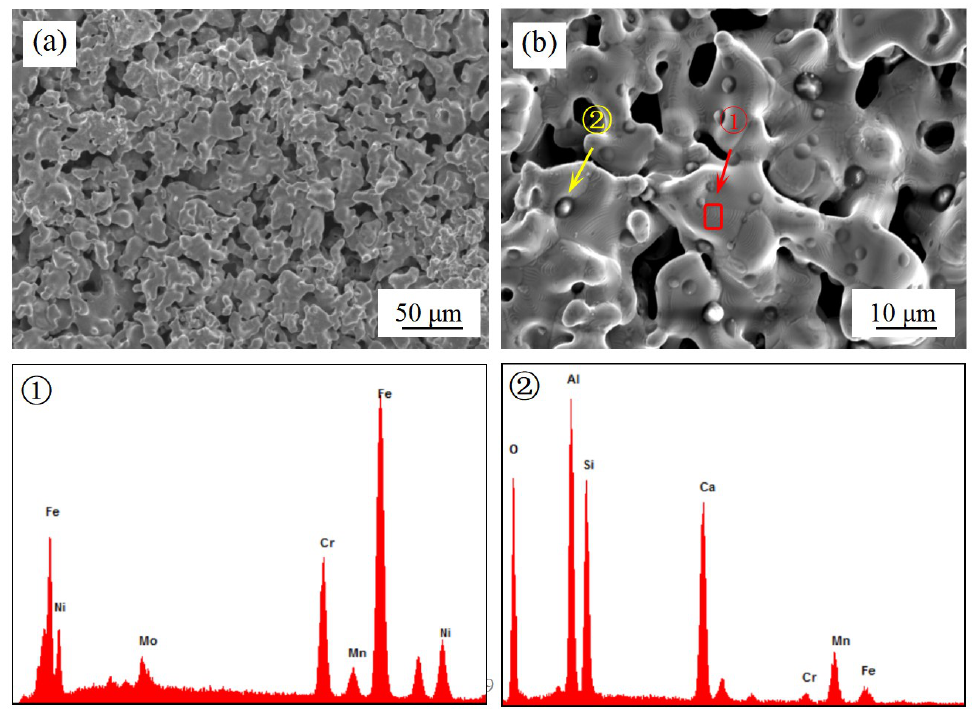
Figure 14. Micromorphology of porous 316 stainless steel at 10 −4 atm and 1200 °C for 180 min; ( a ) macro morphology; ( b ) microscopic morphology of the matrix and impurity particles; ① matrix; and ② impurity particle .